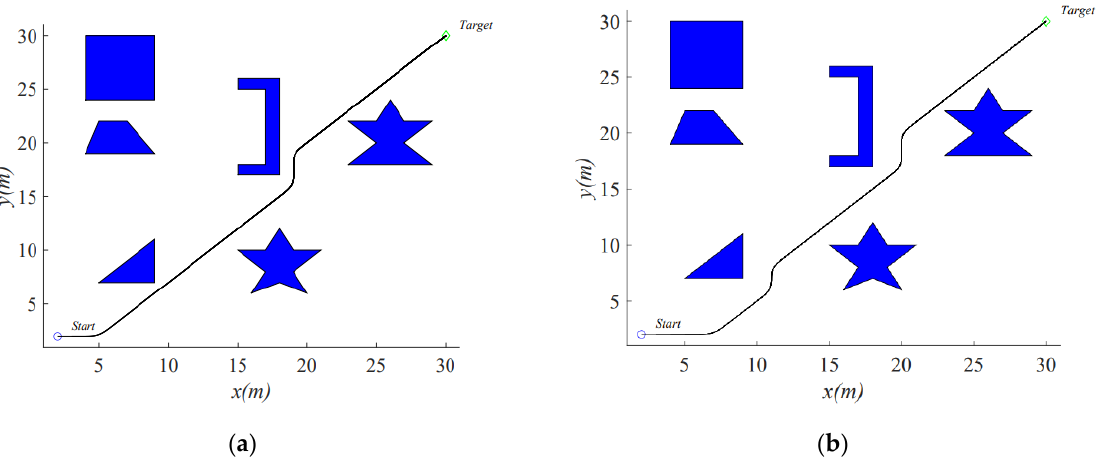
Figure 10. Comparison of trajectory planning algorithms: ( a ) the improved RRT algorithm; ( b ) the improved A* algorithm.